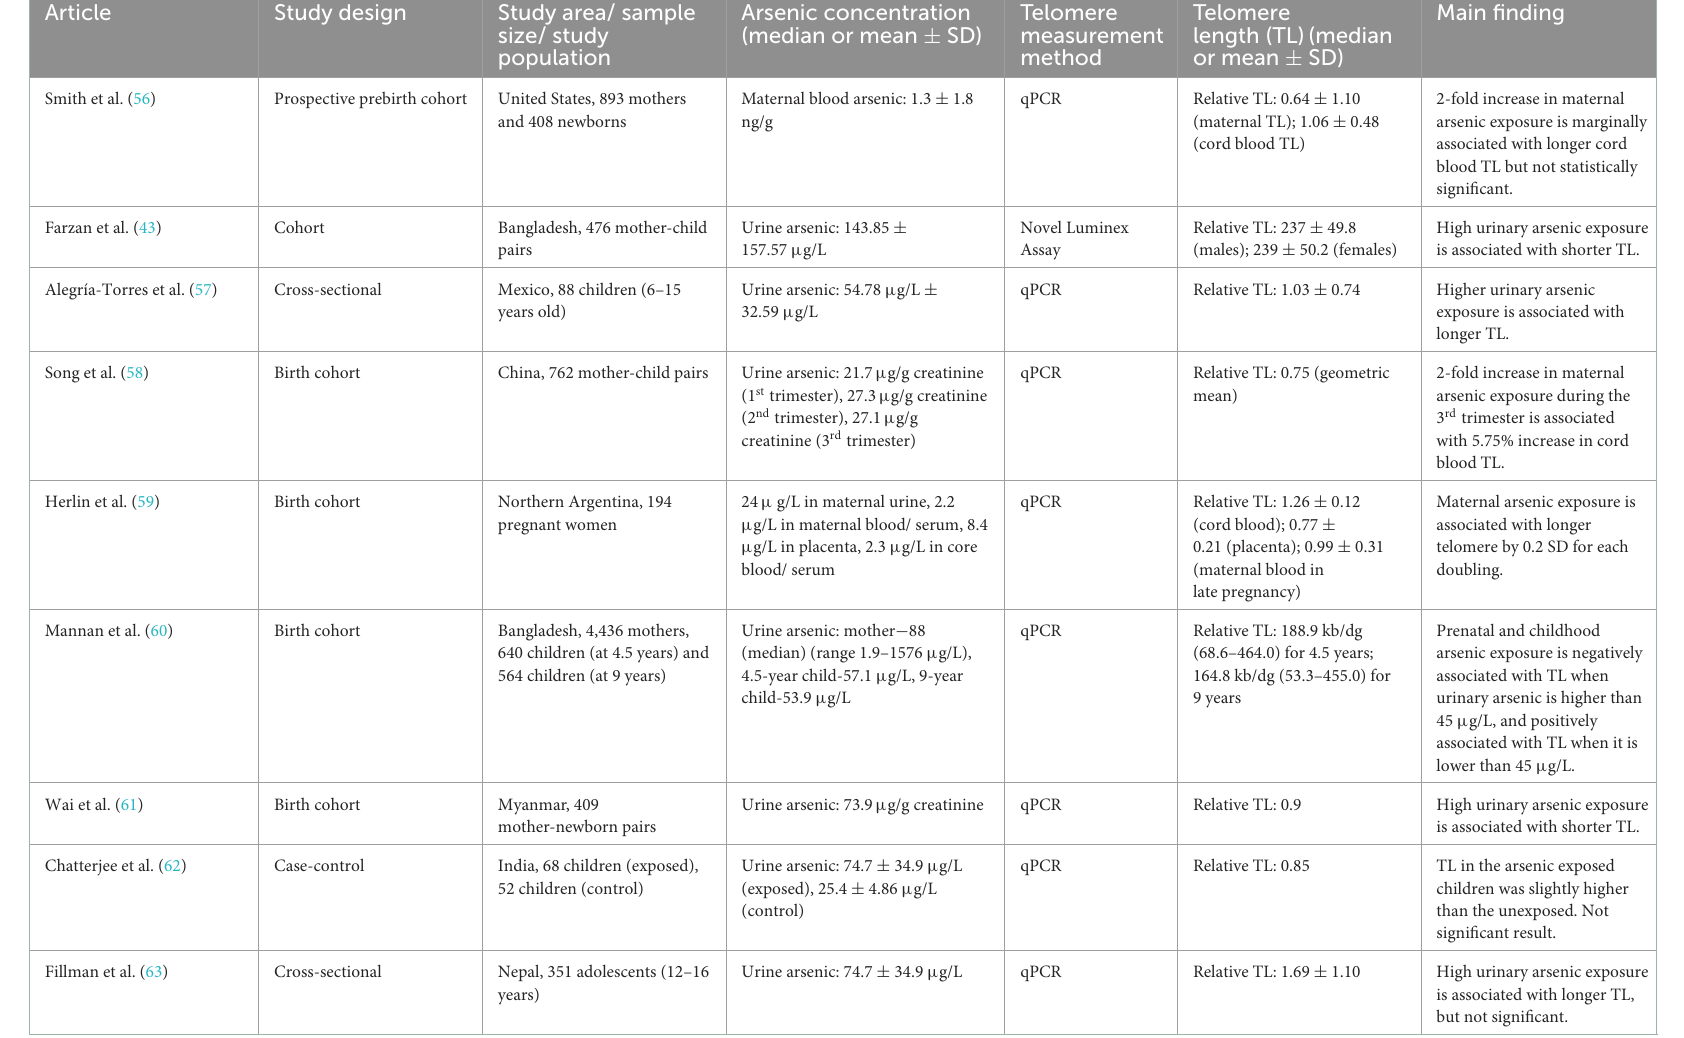
TABLE 2 Summarized studies regarding the associations between arsenic exposure and telomere length in children or